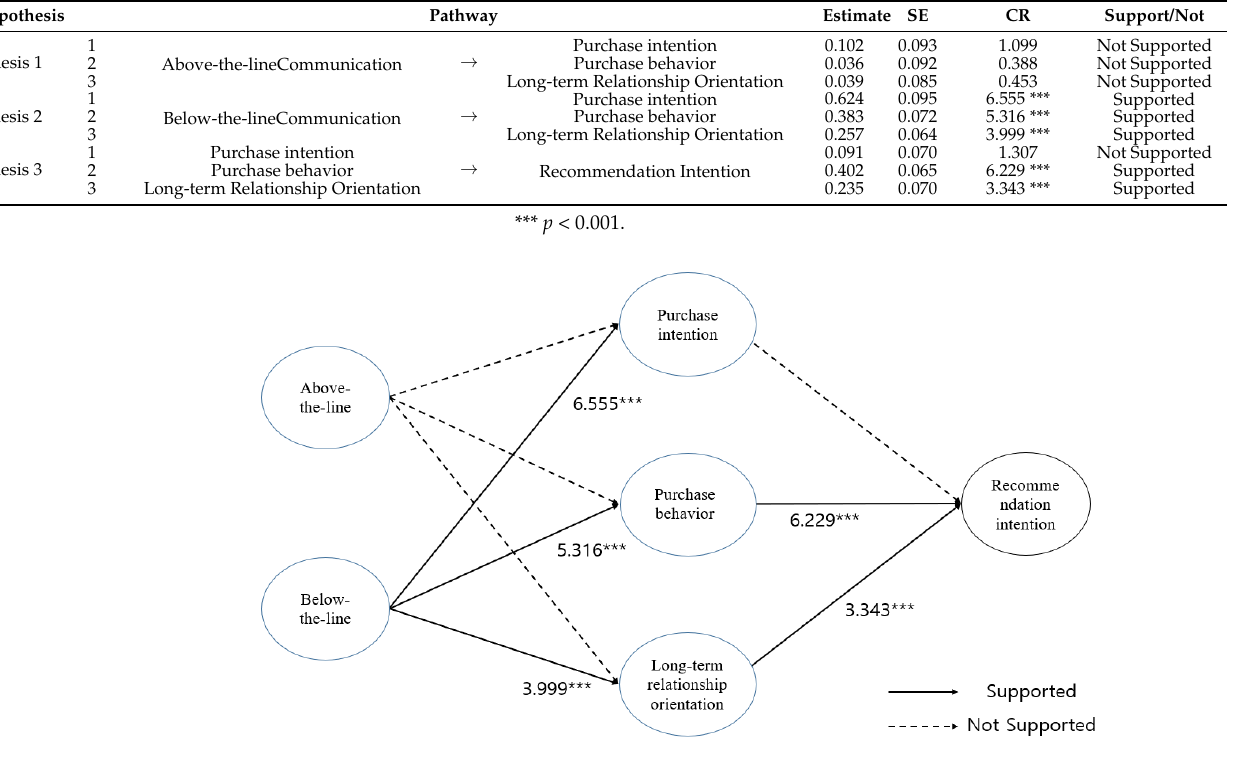
Figure 2. Results of the structural equation model. *** p < 0.001.